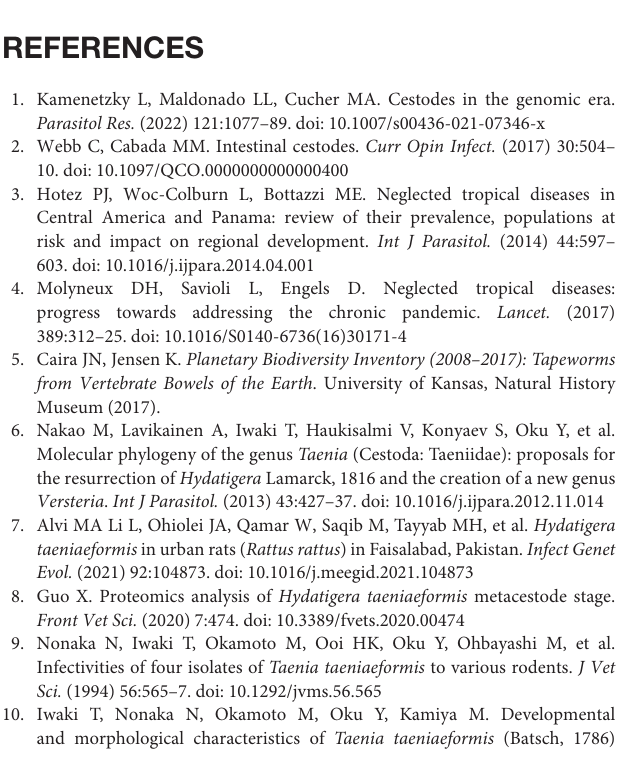
Supplementary Figure S1 | PCR verification of the mt genome of Hydatigera taeniaeformis China isolate. Lane M: DL5000 DNA marker. Lane 1–4: cox3-nad1, nad1-cox1, nad6-cox3, and nad6-cox3. Supplementary Figure S2 | Inferred phylogenetic relationship based on cox1 sequences of H. taeniaeformis ( n = 84) from different hosts and regions. Clade A consisted of 39 haplotypes (designated as A1–A39, A37 in the red font is the cox1 fragment of H. taeniaeformis in this study), clade B included 23 haplotypes (B1–B23), and clade C contained 22 haplotypes (C1–C22), using Neighbor-Joining (NJ) method, with an outgroup H. krepkogorski . Supplementary Dataset | Mitochondrial DNA data. Nucleotide sequence alignments ( cox1 complete haplotypes dataset).